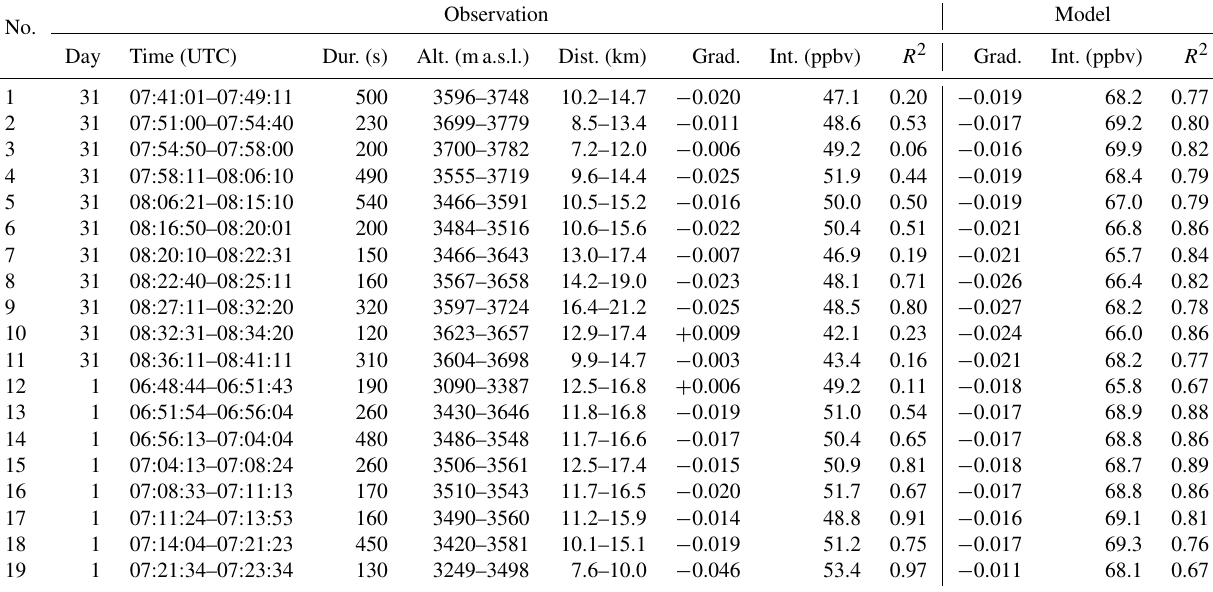
Table 5. Data relating to the major plume encounters and the equivalent model data, depicted in Figs. 4 and 5 (observations) and Figs. S8 and S9 (model); dur: duration of plume encounter; alt: range of altitudes of plume encounter; dist: distance from Etna; grad: gradient of line of best fit of O 3 vs. SO 2 slope; int: y intercept of this line.